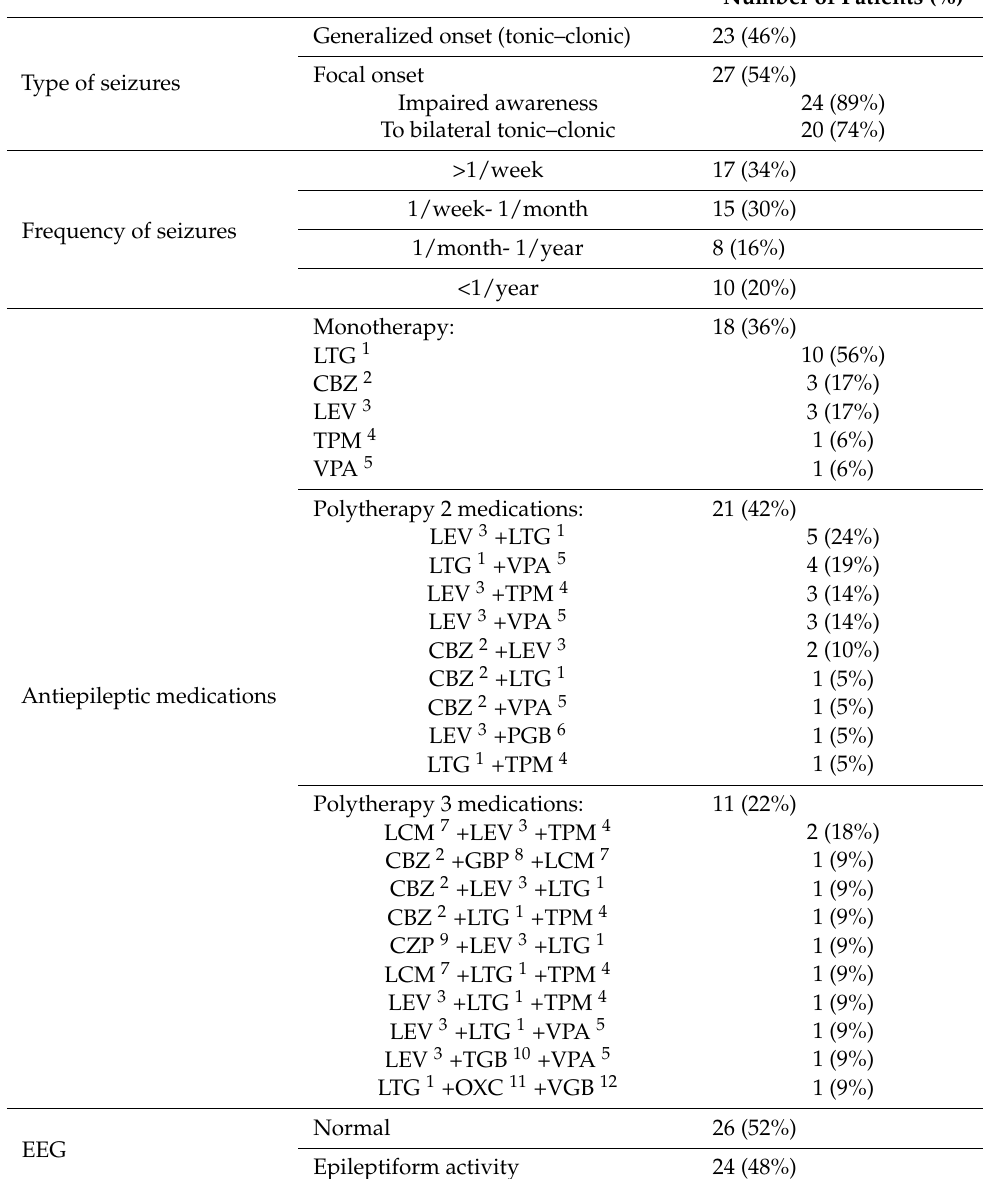
Table 1. Characteristics of epilepsy in the study